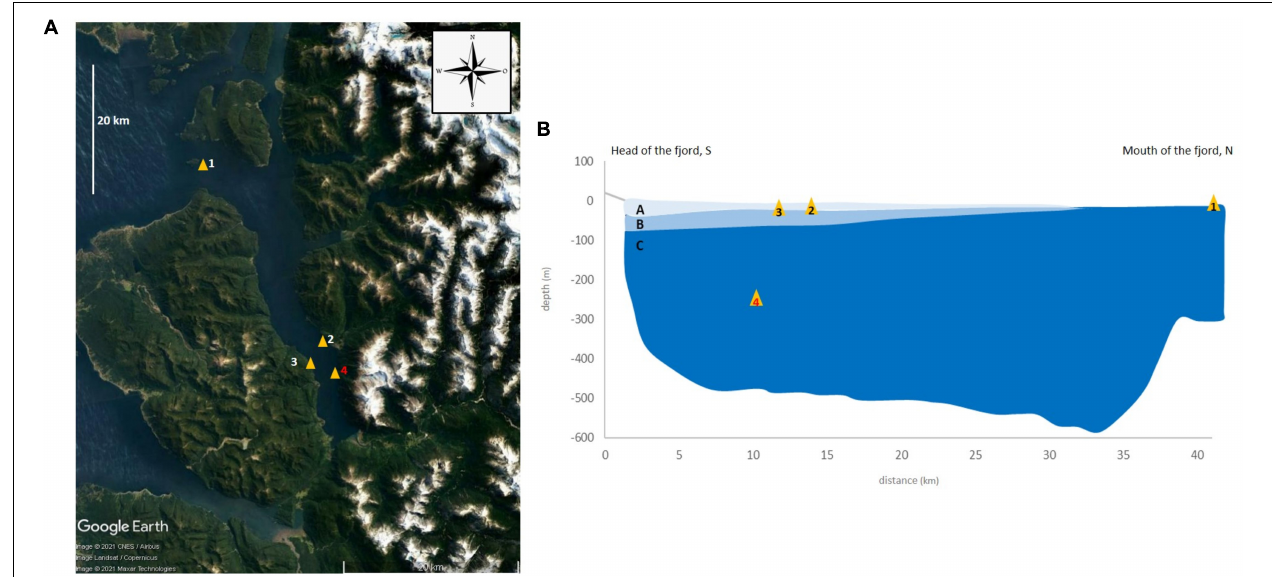
FIGURE 1 | Location and information on coral samples collected in Comau Fjord (A) : (1) Lilihuapi Island (ILC, 42 ◦ 09 (cid:48) S 72 ◦ 35 (cid:48) W), − 20 m; (2) Punta Huinay (PHC, 42 ◦ 22 (cid:48) S 72 ◦ 25 (cid:48) W), − 20 m; (3) Cross Huinay (XHC, 42 ◦ 23 (cid:48) 55 (cid:48)(cid:48) S, 72 ◦ 27 (cid:48) 18 (cid:48)(cid:48) W), − 20 m; (4) Punta Gruesa (PGC_D, 42 ◦ 24 (cid:48) S 72 ◦ 25 (cid:48) W), − 250 m, D, Deep indicated in red. Simplified scheme of water layers and movement of the Comau Fjord (B) . A, surface freshwater layer; B, brackish water; and C, deep saline water; N, north S, south (Google Earth, Image © 2021 CNES/Airbus, Landsat/Copernicus, Maxar